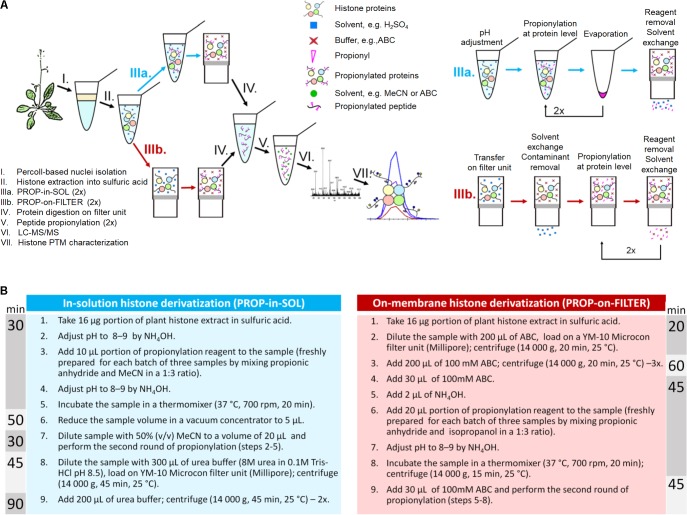
Plant histone sample preparation workflow for LC-MS/MS. (A) An illustrative scheme of the workflow. (B) Protocol variants for protein derivatization; time needed for each derivatization protocol is depicted.